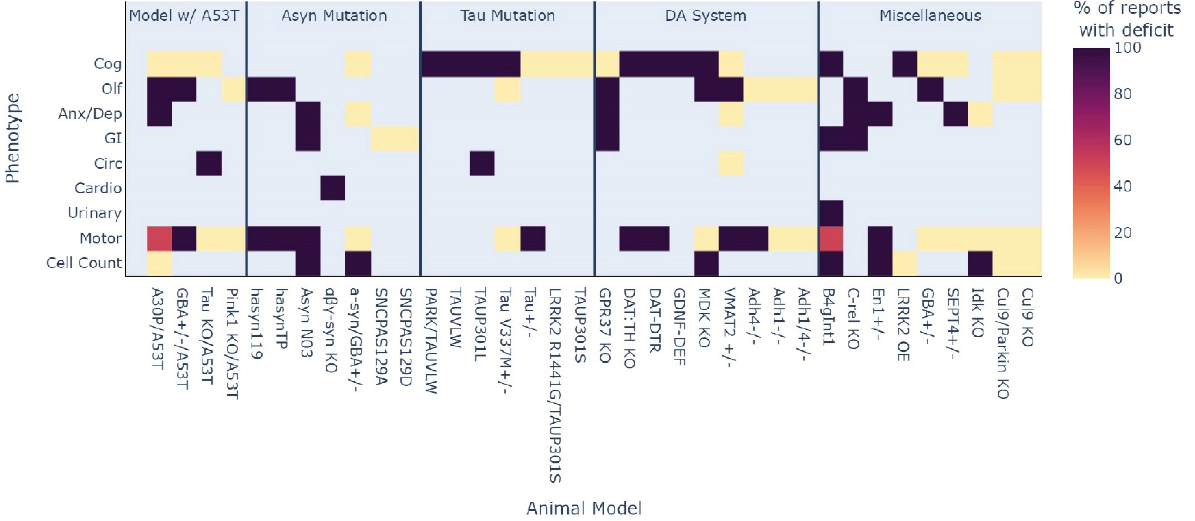
Figure A1. Heatmap summary of the presentation of all phenotypes across all lesser-known animal models. Colours represent the percentage of studies that showed an expected impairment of the phenotype where dark purple is 100% and pale yellow is 0% of studies. Animal models are loosely grouped into 5 categories; double mutant models with the A53T mutation, models containing a mutation in alpha-synuclein, models containing a mutation in Tau, mutations that impact the DA system and miscellaneous models that target other pathways.